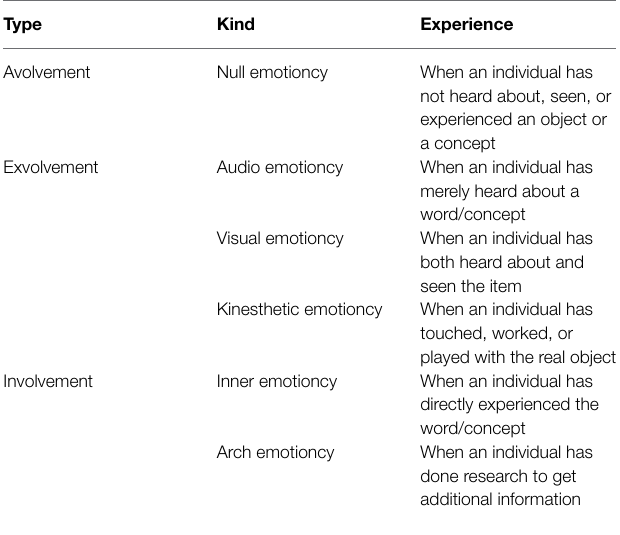
TABLE 2 | Emotioncy types and